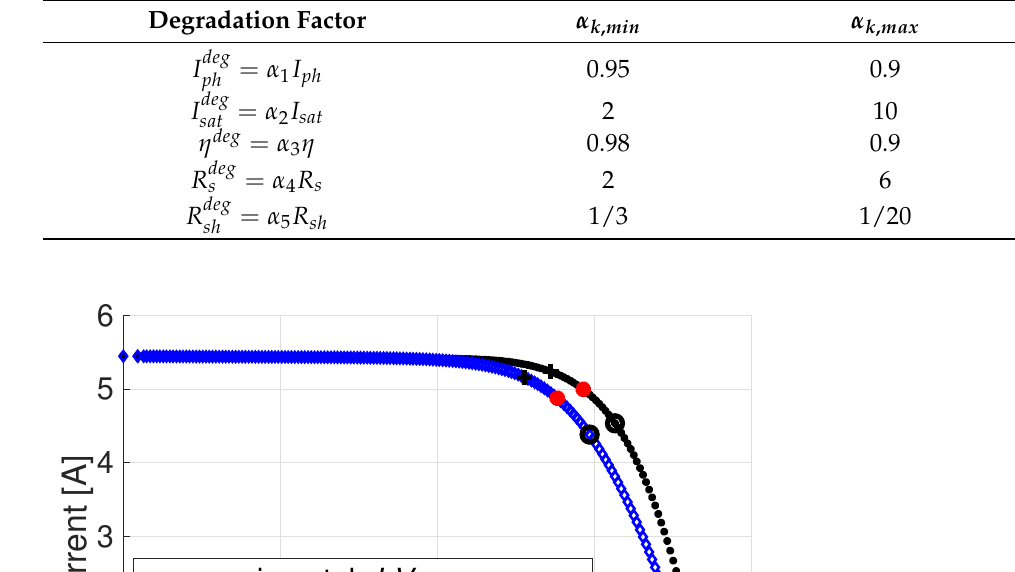
Table 4. SDM parameters variation for generating degraded I - V curves.